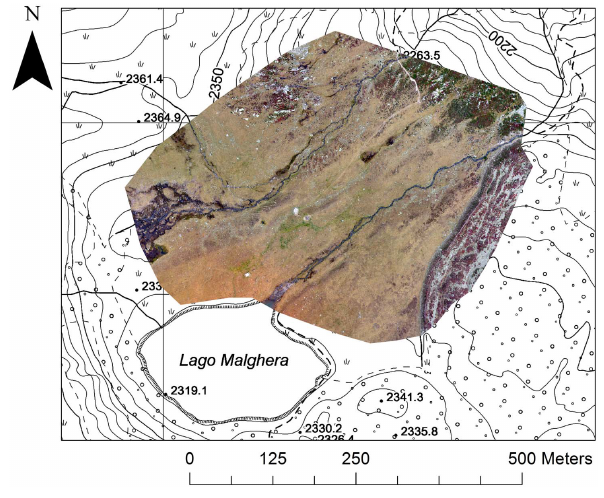
Figure 3. Orthophoto of the survey performed on 26 September 2013.